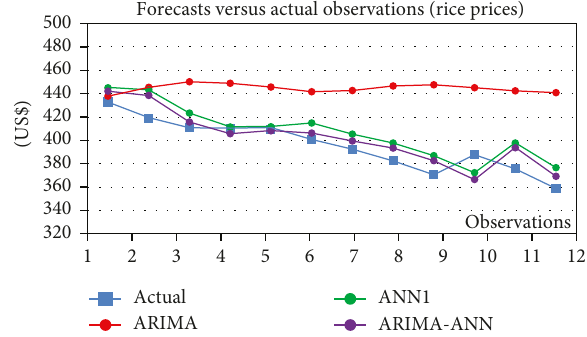
Figure 6: Forecasts of rice prices versus actual observations for the 12 testing records (with the use of ARIMA, ANN ARIMA-ANN models).